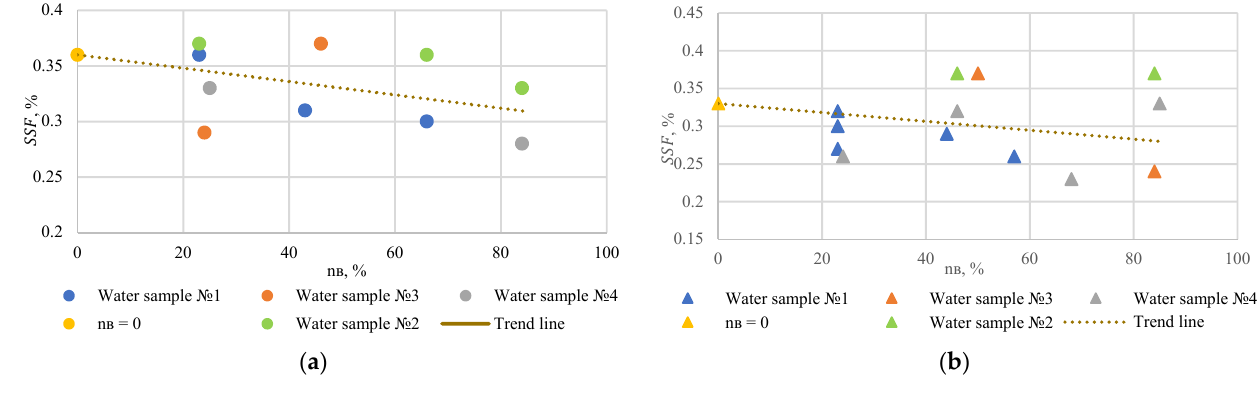
Figure 3. Changes in the SSF coefficient: ( a ) «X» oil; ( b ) «Y» oil. The SSO coefficient for oil «X», as the WOE water cut increases, grows from 0.36 to 1.37–1.77% (Figure 4a); for oil «Y»—from 0.33 to 1.49–2.19% (Figure 4b). Theoretical values of SSO were derived from expression 4: